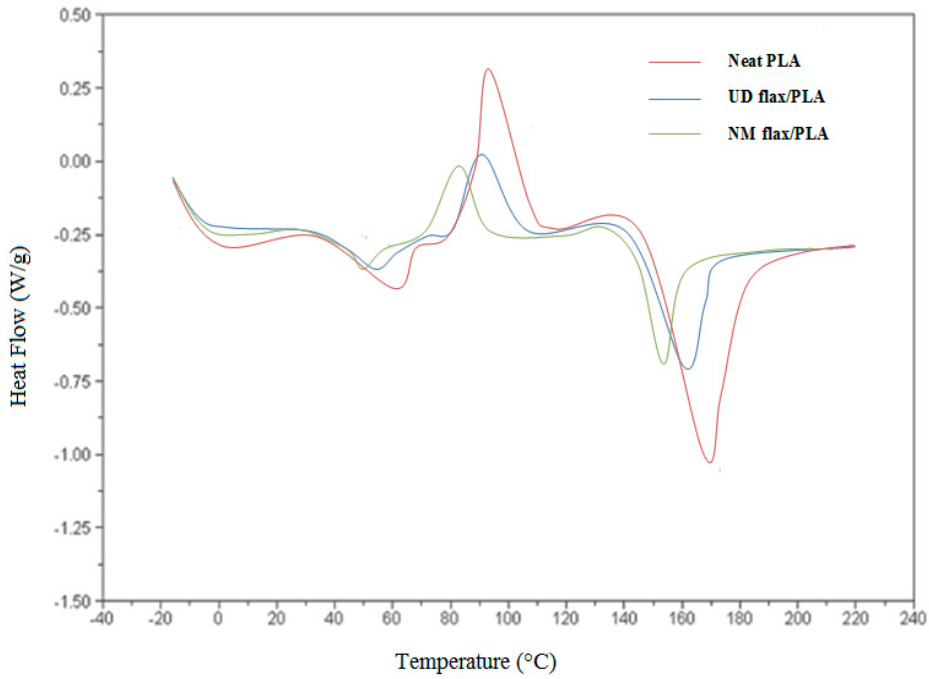
Figure 6. DSC curves of first heating cycle as a function of temperature of neat PLA and flax/PLA biocomposites.